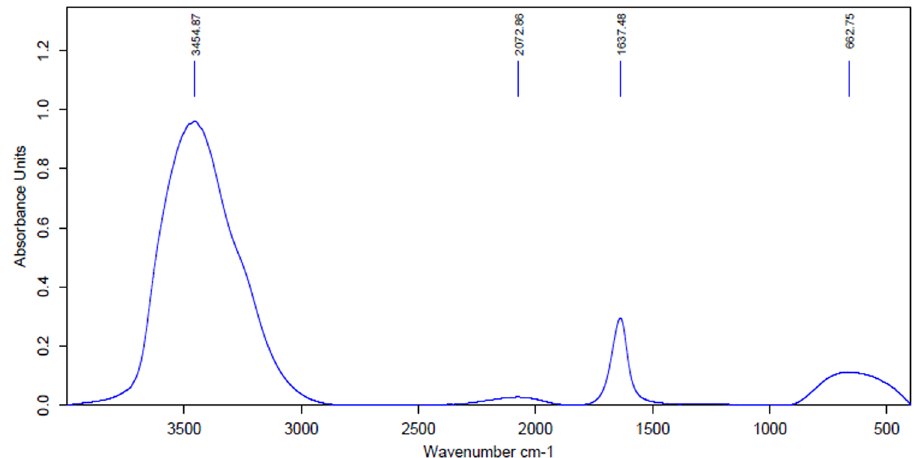
Figure 1: FT - IR spectrum of walnut leaf